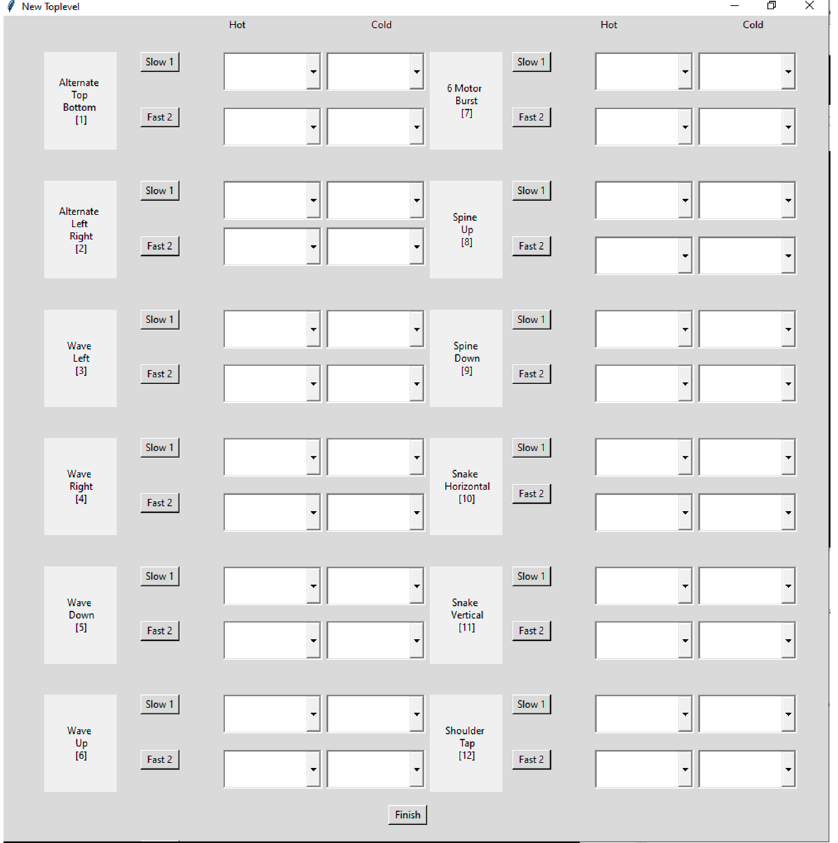
Figure 2. A screenshot of the GUI used by the experimenter to send vibrotactile patterns to the Haptic Chair.